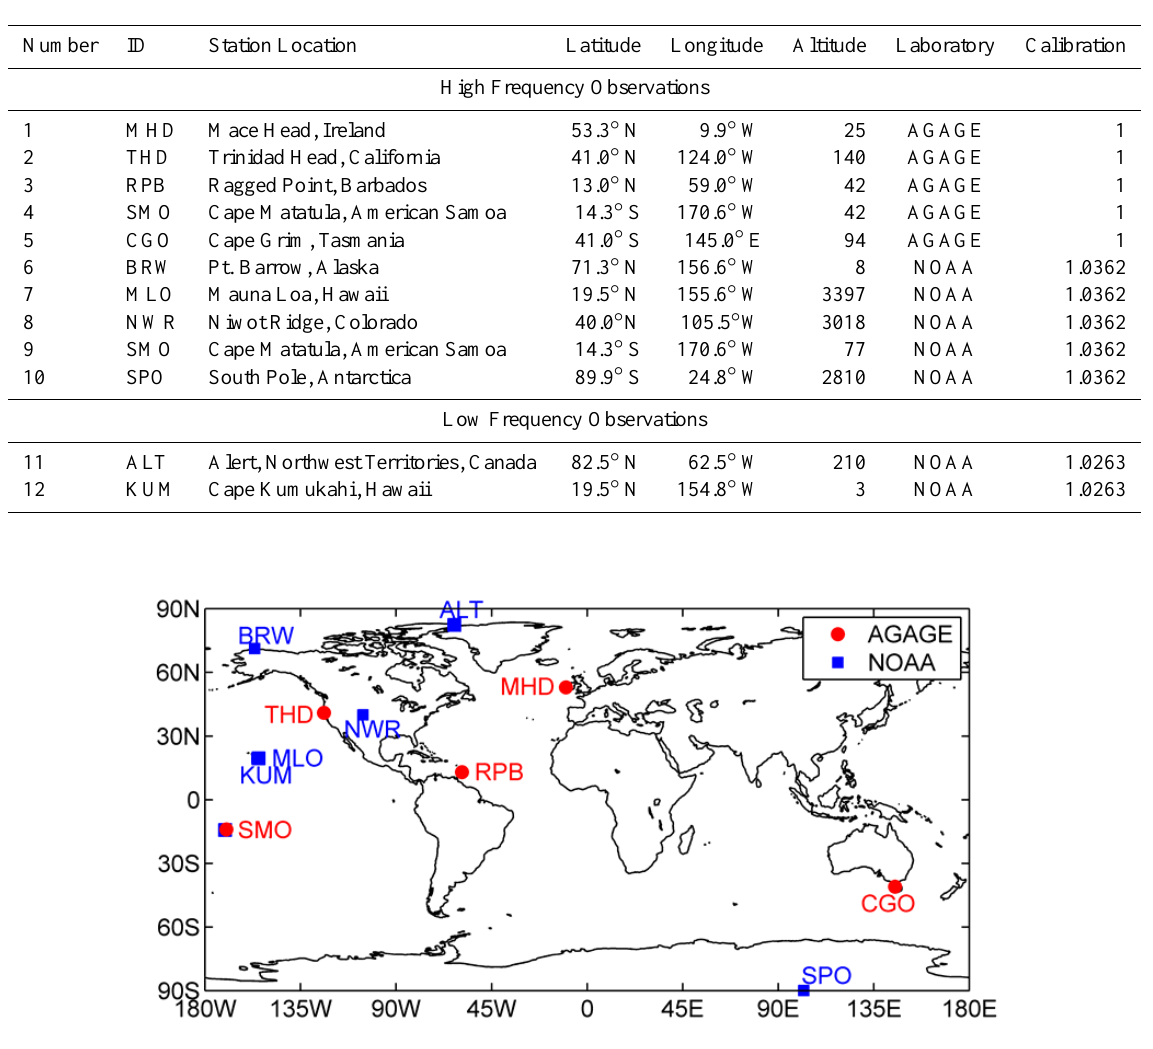
Table 1. Location of the CCl 4 measuring stations and their calibration ratios relative to AGAGE (dividing by these ratios places measurements on the AGAGE scale).